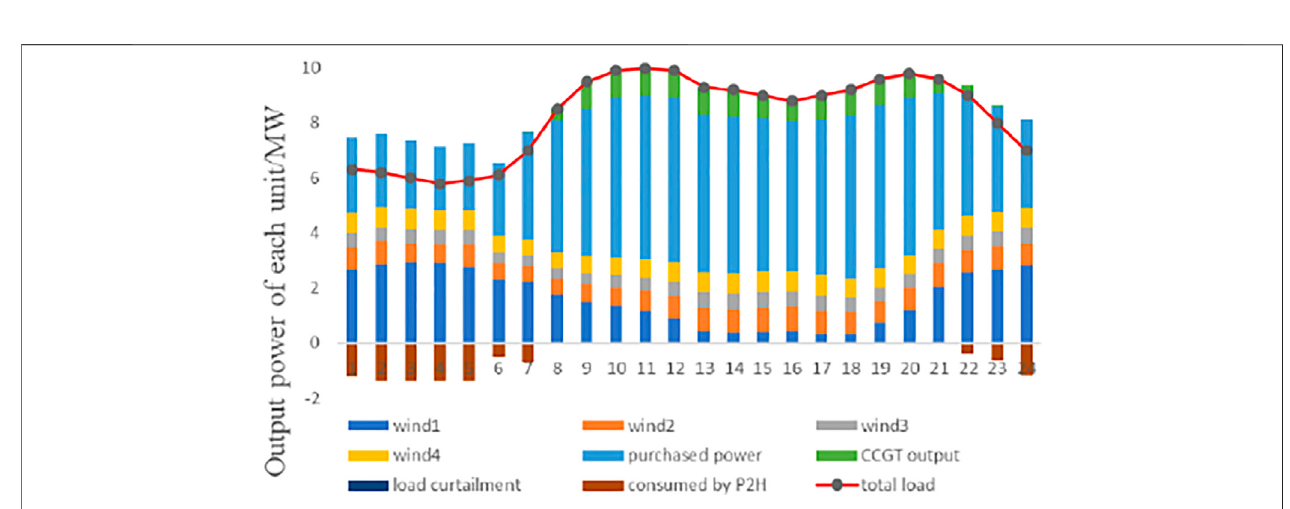
FIGURE 11 | Optimal generator outputs of case